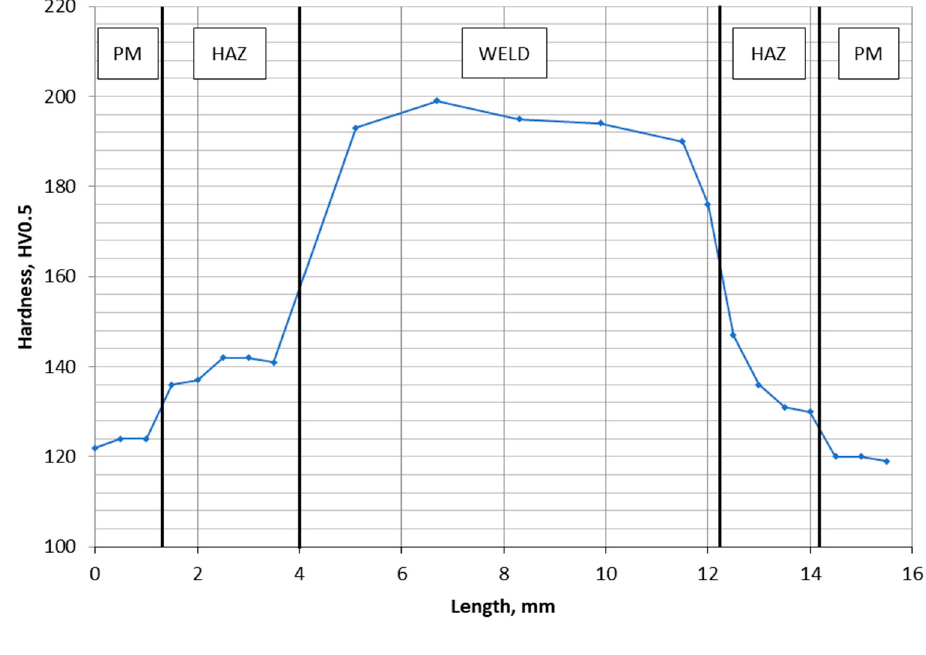
Figure 19. Macrostructure of welded joint with HV5 hardness measurement lines marked.